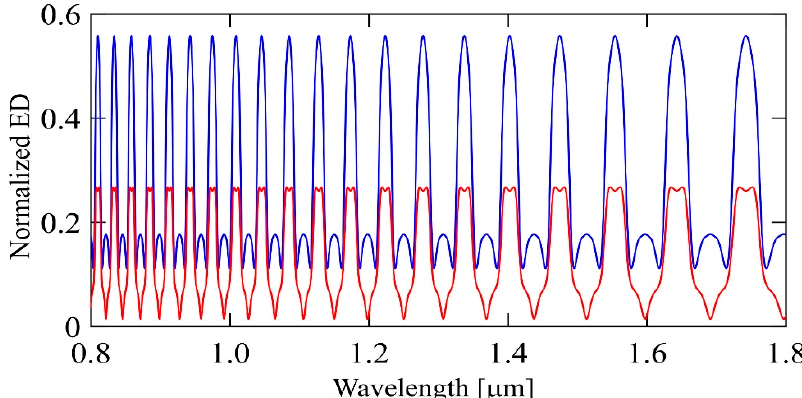
Figure 2. The mindfulness simulation signals where the blue and red colors are the polaritons’ spin-up and spin-down. This is the steady-state signals at the optimum condition. A Rabi oscillation occurs when the energy level is reduced to be n = 2. The oscillation is collapsed, when n = 1, and the energy state becomes a continuous energy state (only one level).